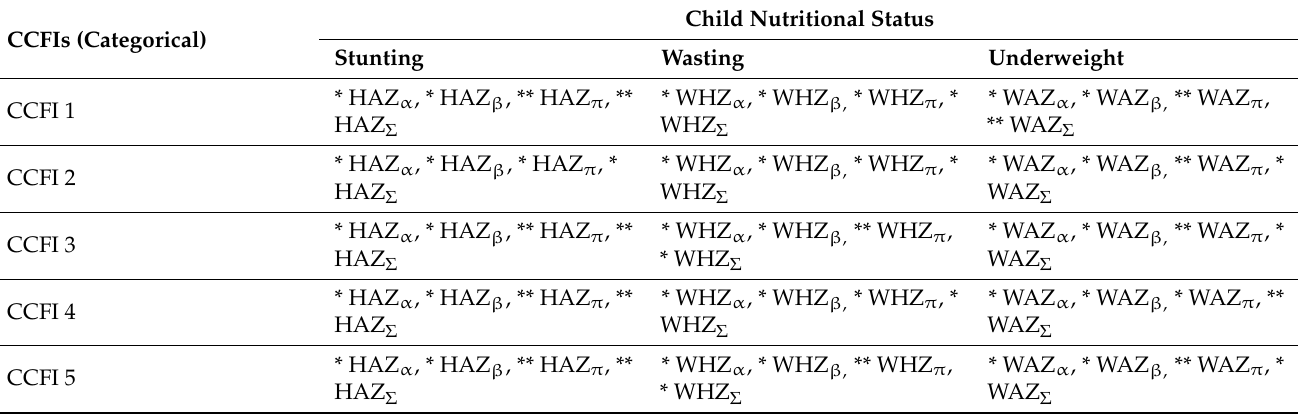
Table 5. Predictive utility of categorical forms of CCFIs for child nutritional status. Child Nutritional